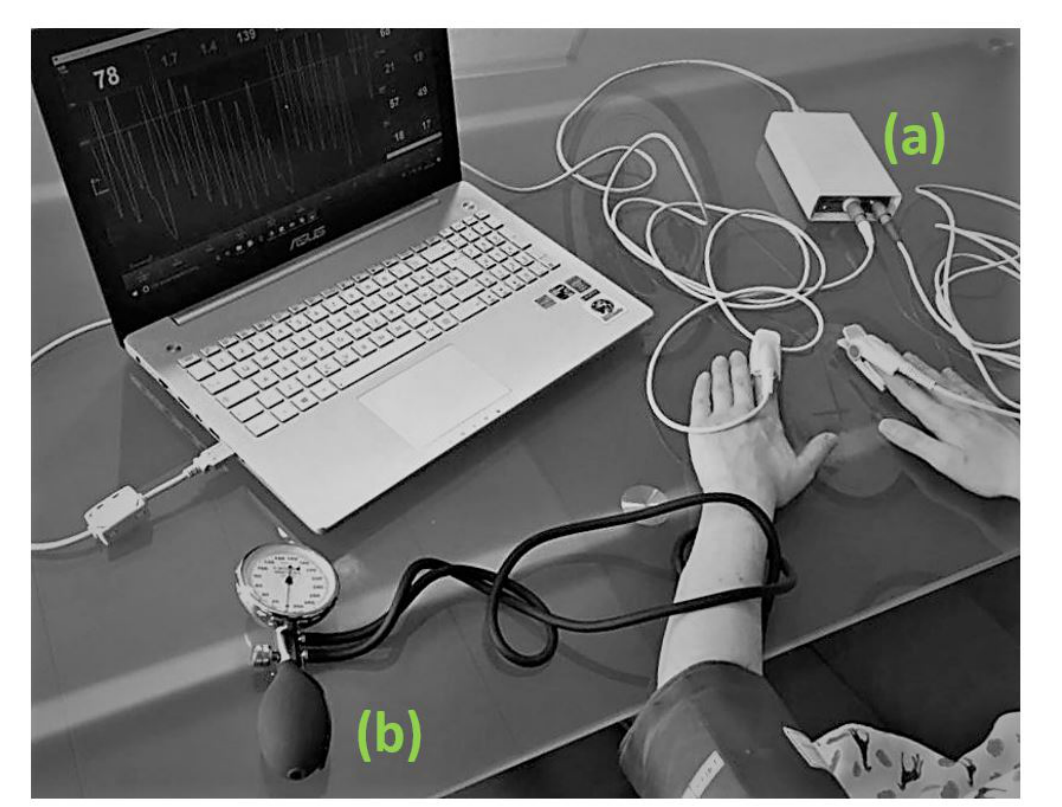
Figure 2. PPG-signal acquisition setup: ( a ) VenoScreen R (cid:13) (medis) with two photoplethysmography sensors; and ( b ) sphygmomanometer with cuff. Acquired signals were processed by the VenoScreen R (cid:13) (medis)